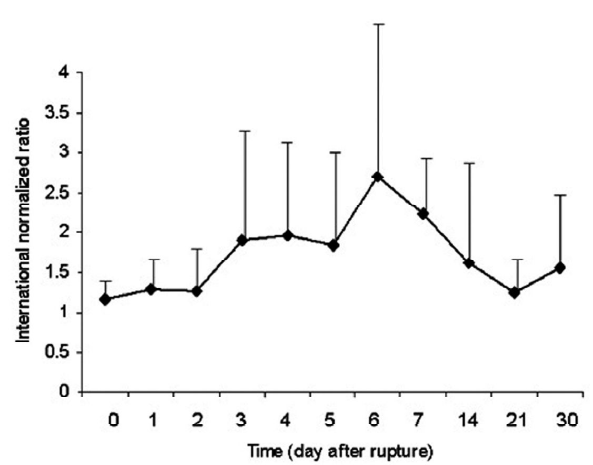
Fig. 4 - Kinetics of partial thromboplastin time after myocardial rupture